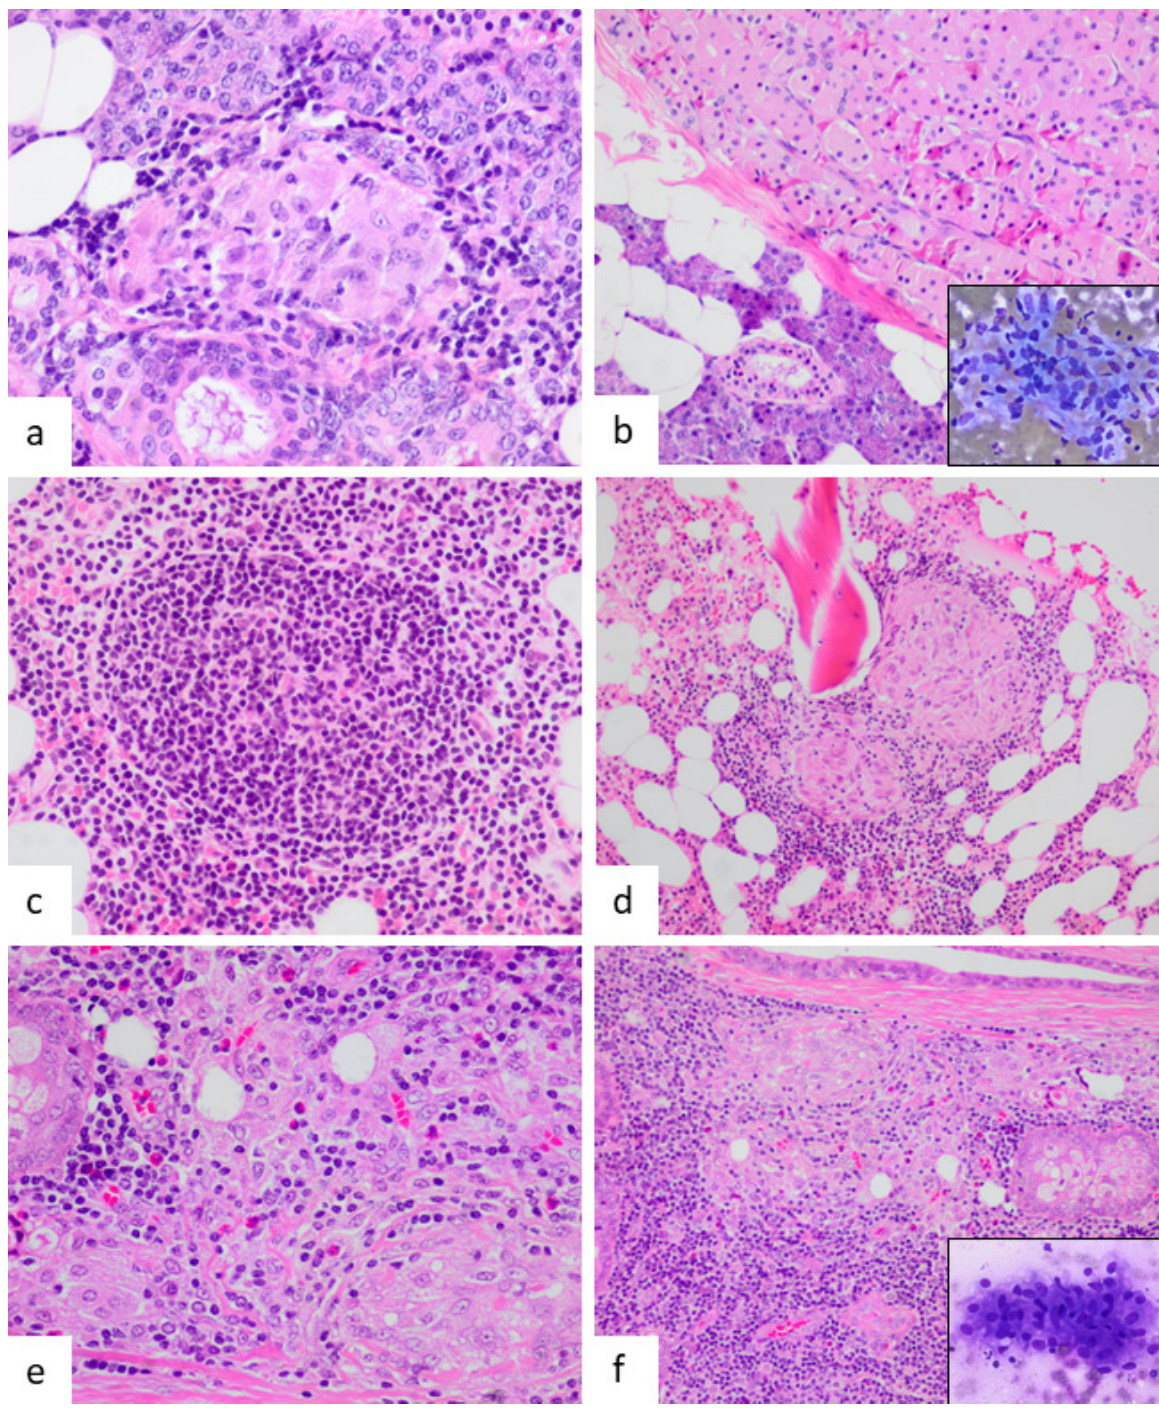
Figure 3. ( a , b ) Peritumoral granulomas in the case of parotid oncocytoma (case 2) (HE, ×600 and ×200, respectively). The inset reveals a granuloma in a fine needle aspiration sample of an enlarged mediastinal lymph node performed 30 months later (Diff-Quik, ×400). ( c , d ) Bone marrow showing follicular lymphoma involvement and numerous non-necrotizing granulomas (case 3) (HE, ×400 and ×200, respectively). ( e , f ) Two images of sebaceous lymphadenoma showing intratumoral granulomas (case 5) (HE, ×200 and ×400).